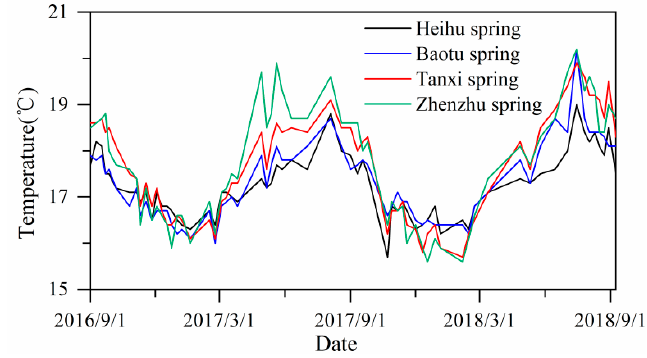
Figure 4. Curves of the water temperature duration of the four major springs. Table 2. List of characteristic values of spring water temperature data.